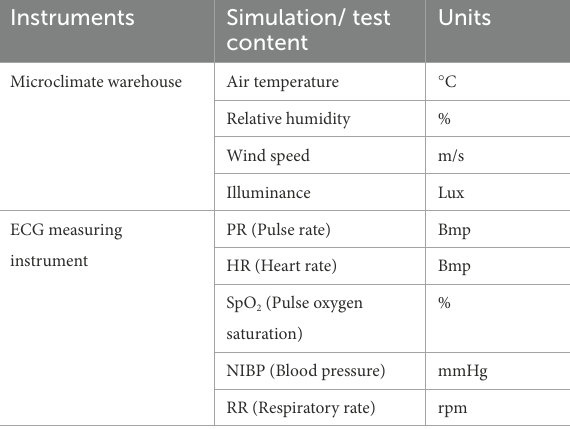
TABLE 2 Experimental instruments.